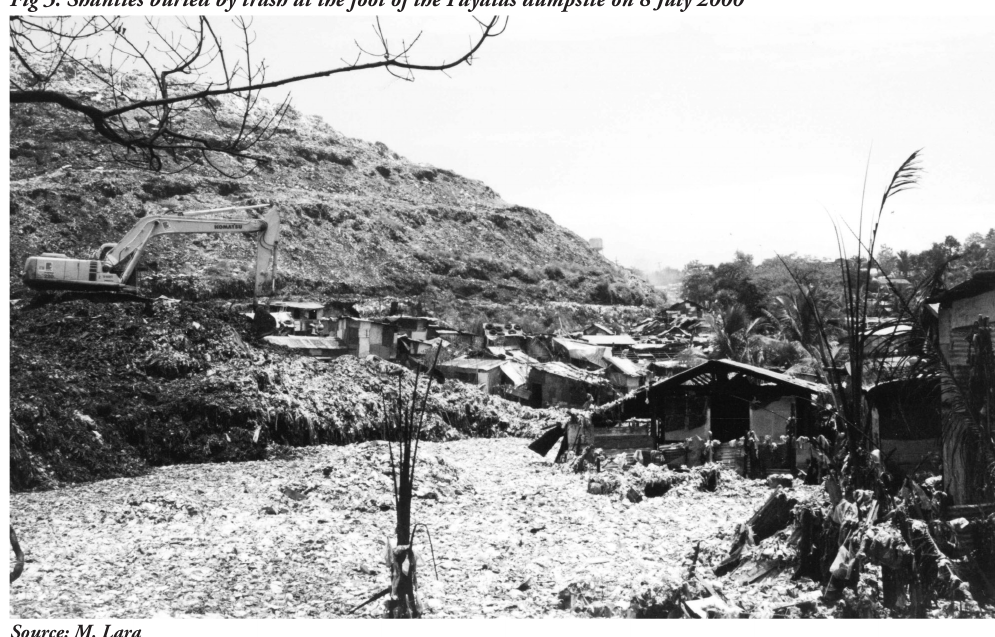
Fig 3. Shanties buried by trash at the foot of the Payatas dumpsite on 8 July 2000